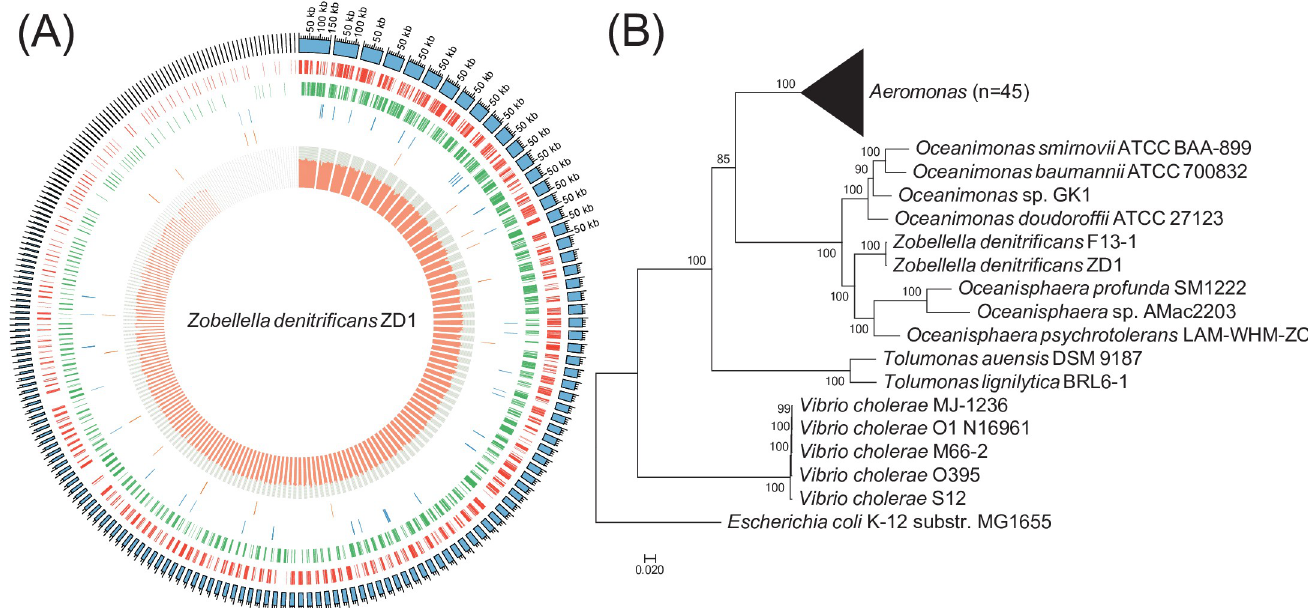
Fig 1. Genome map and phylogenetic tree for Zobellella denitrificans ZD1 strain. (A) Six rings, from outer to inner, represent (1) assembled scaffolds, (2) genes in the forward strand, (3) genes in the reverse-complement strand, (4) transfer RNA (tRNA) genes, (5) ribosomal RNA (rRNA) genes, and (6) the GC content. (B) Phylogenetic tree constructed from 287 single copy marker